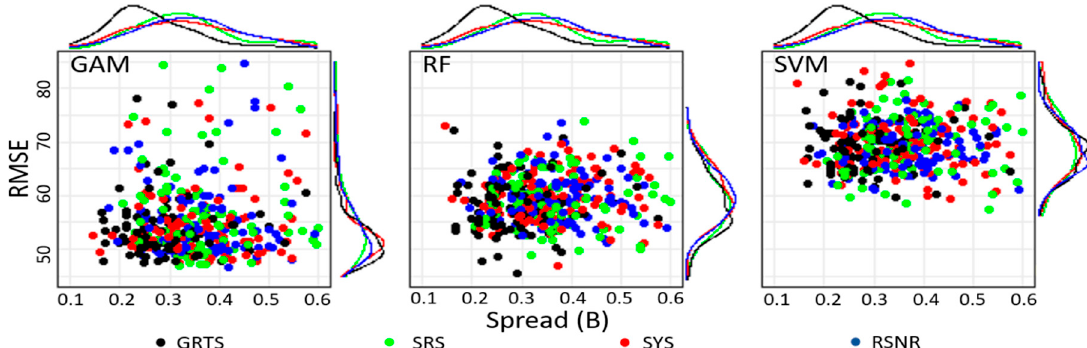
Figure 9. Root mean squared error (RMSE) versus spread values (B) for the top three estimation techniques given nonlinear response surface sample design with 40% introduced noise. Densities of RMSE and B values are presented to the right and above each graph. GAM = general additive model; RF = random forests; SVM = support vector machine; SRS = simple random sample; SYS = systematic random sample; GRTS generalized random tessellation stratified; and RSNR = random sample near roads.